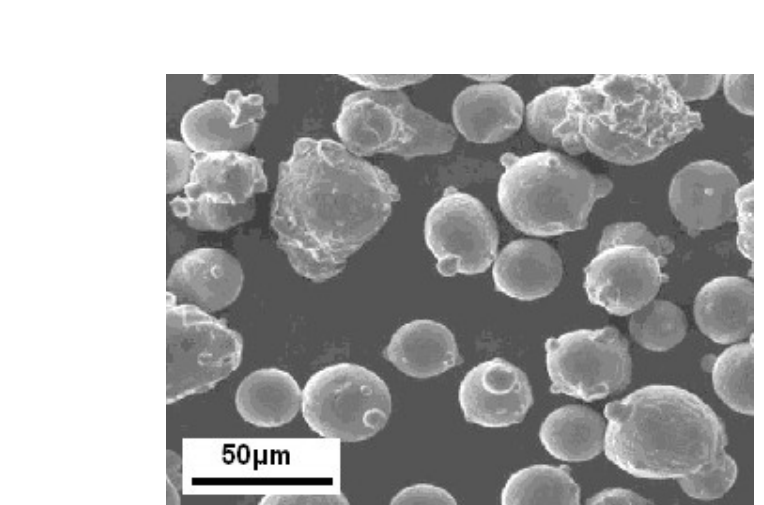
Figure 1 – (SEM) Scanning electron micrography of Co32Ni21Cr8Al0.5Y powder